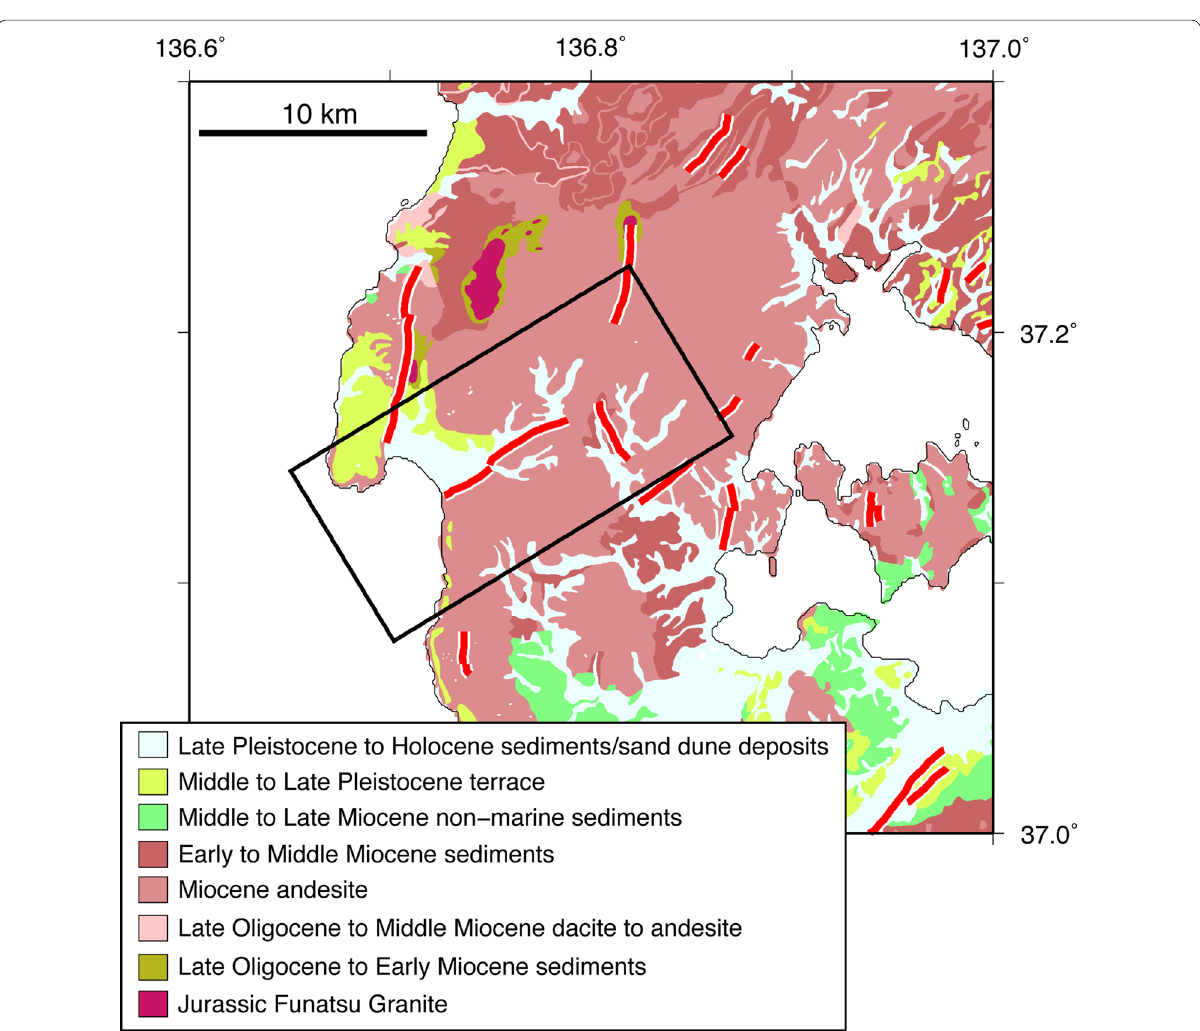
Fig. 2 Geological map around the TNF. Geology information is based on the seamless digital geological map (1:200,000) published by the Geological Survey of Japan.